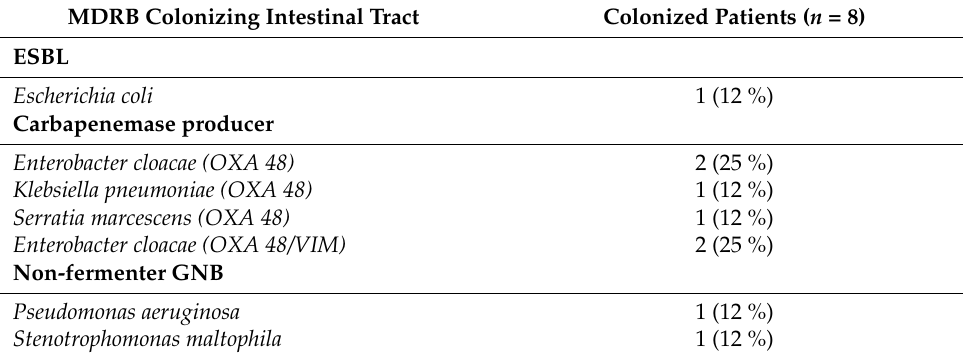
Table 2. Information of the colonizing bacteria detected in the colonized group. ESBL: extended- spectrum β -lactamase, GNB: Gram-negative